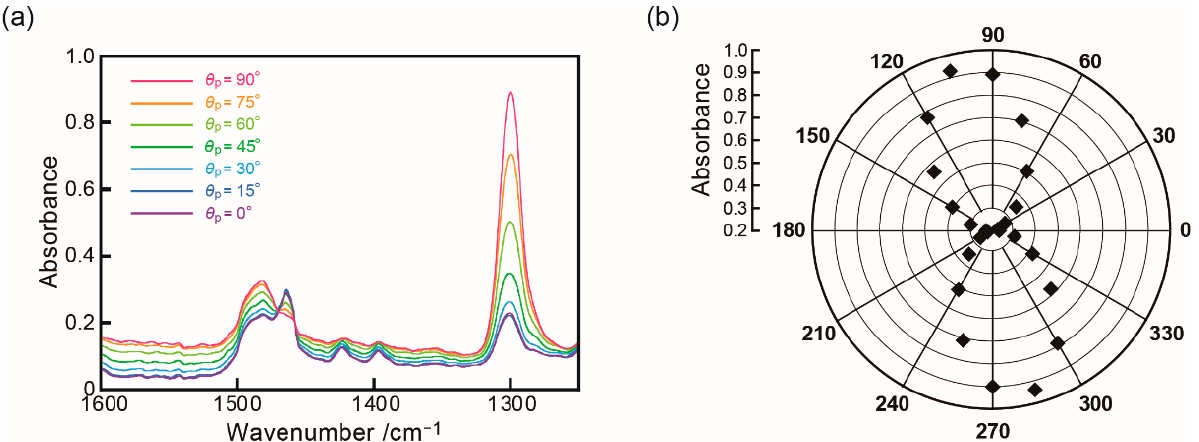
Figure 6. ( a ) θ p -dependence of IR spectra of the pQpdS-Ch /H 2 O (X = 70) mixture in the Col h phase. ( b ) A polar plot of the absorbance of the S=O stretching vibration ( ν S=O ) observed at 1301 cm –1 . The phase transition behavior of these mixtures has been further examined using DSC measurements. The DSC measurements were performed in the temperature range from 0 to 80 ◦ C at the heating/cooling rate of 10 ◦ C min − 1 . The obtained DSC charts on cooling and heating are shown in Figure 7a,b, respectively. In the cooling process, an exothermic peak is found for each sample when X ≤ 80. These peaks can be attributed to the enthalpy change at the phase transition from an isotropic phase to an LC phase. It can be seen that the peak position shifts to higher temperature region as the decrease of X, which is consistent with the isotropization temperatures observed by POM observation. The thermal